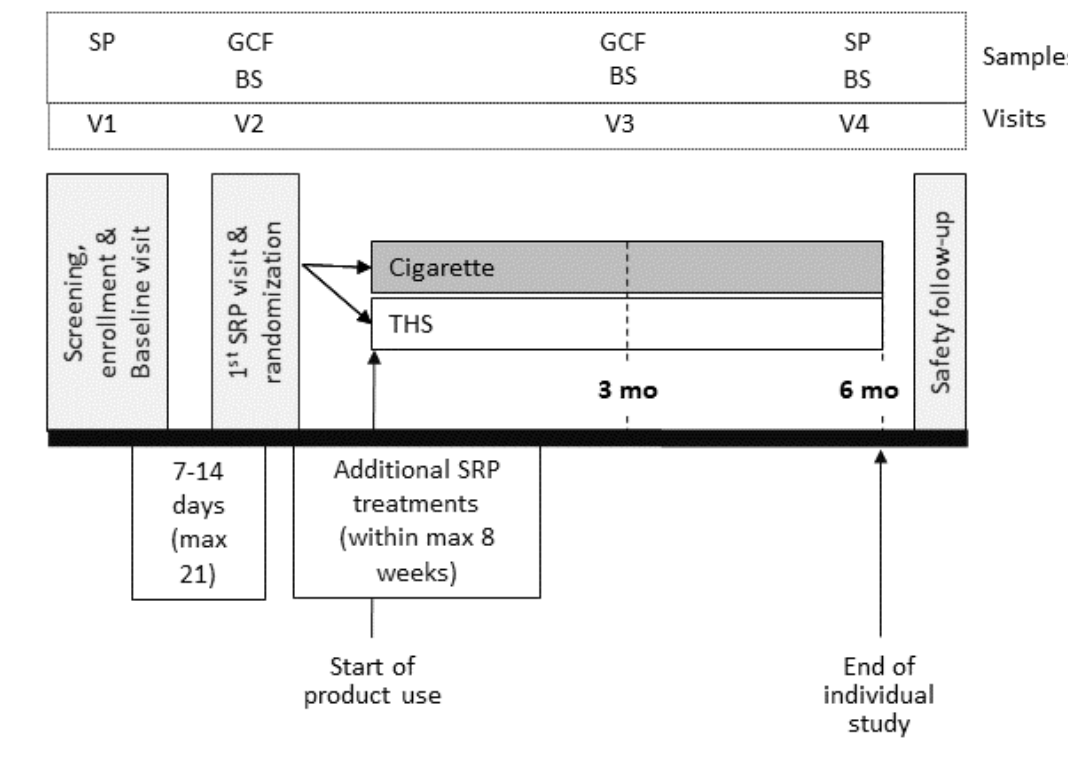
Figure 1. Design of the study. Eligibility criteria were checked at V1. Enrolled subjects were randomized at V2. Periodontal assessments were performed at V1, V3, and V4. Times of collection of buccal samples are indicated on the chart. BS: buccal swabs; GCF: gingival crevicular fluid; mo: month; SP: subgingival plaque; SRP: scaling and root planing; V: visit; THS: Tobacco Heating